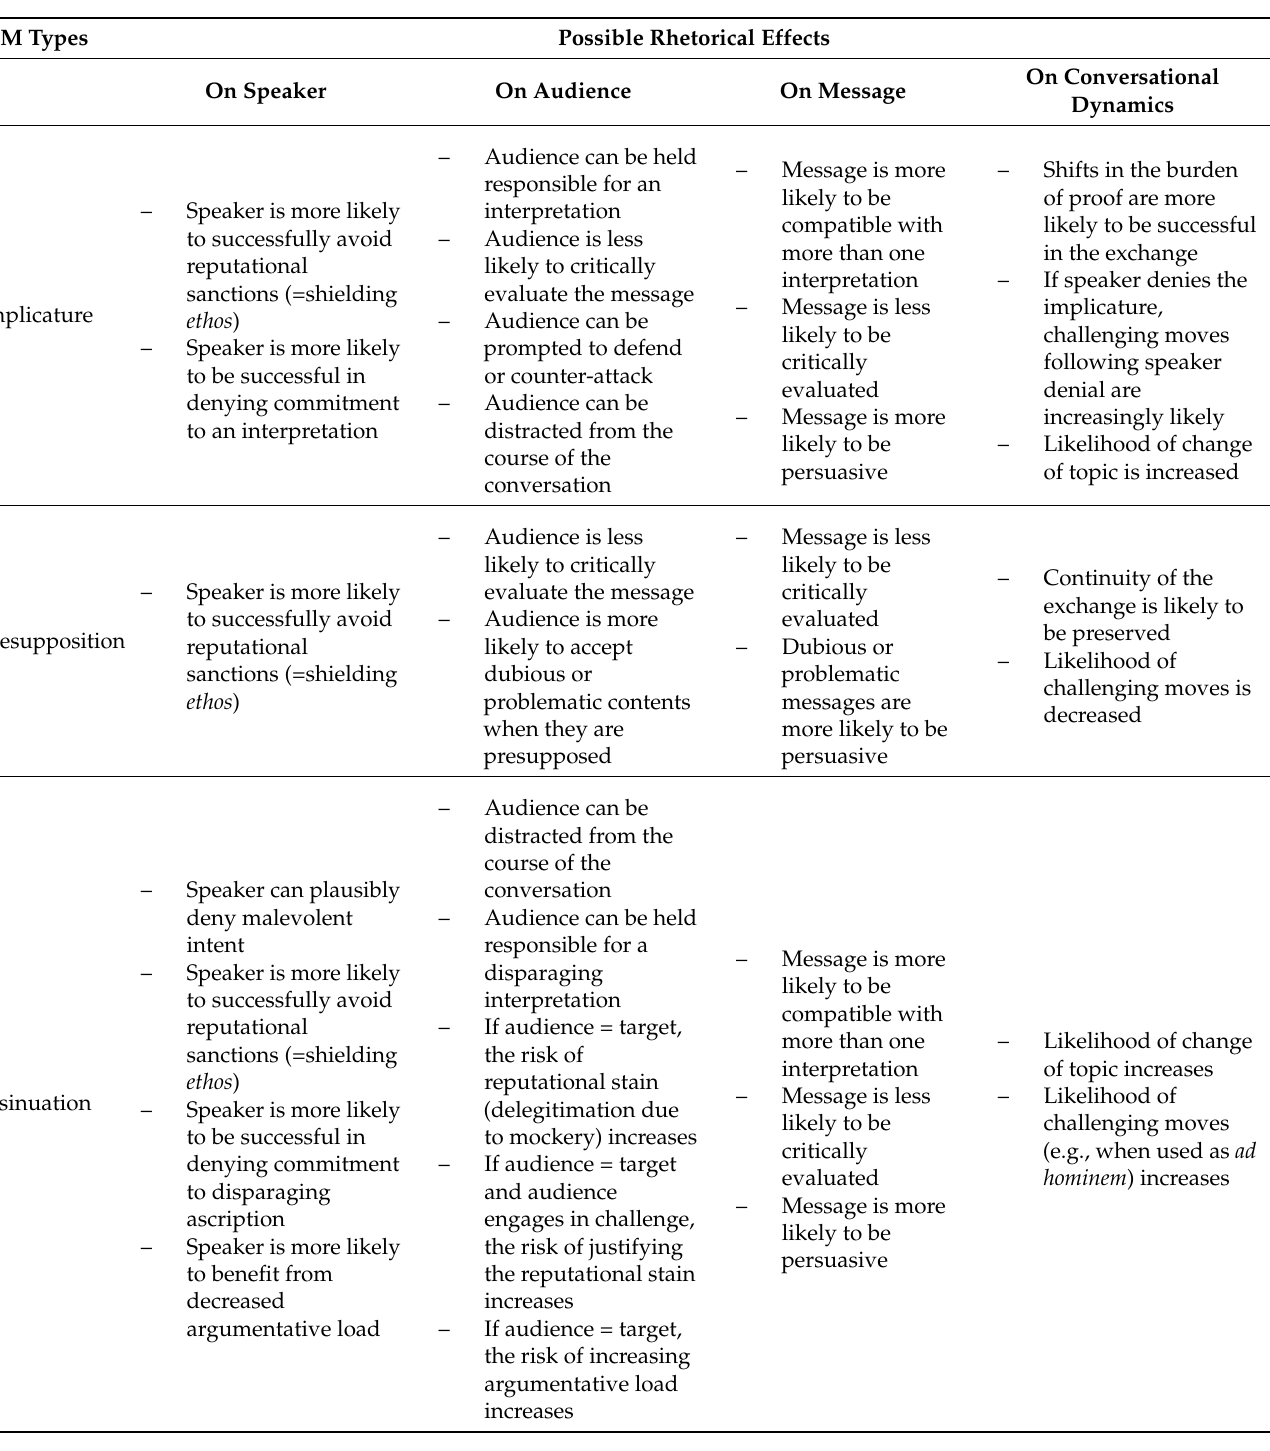
Table 1. Possible rhetorical effects for different types of pragmatic